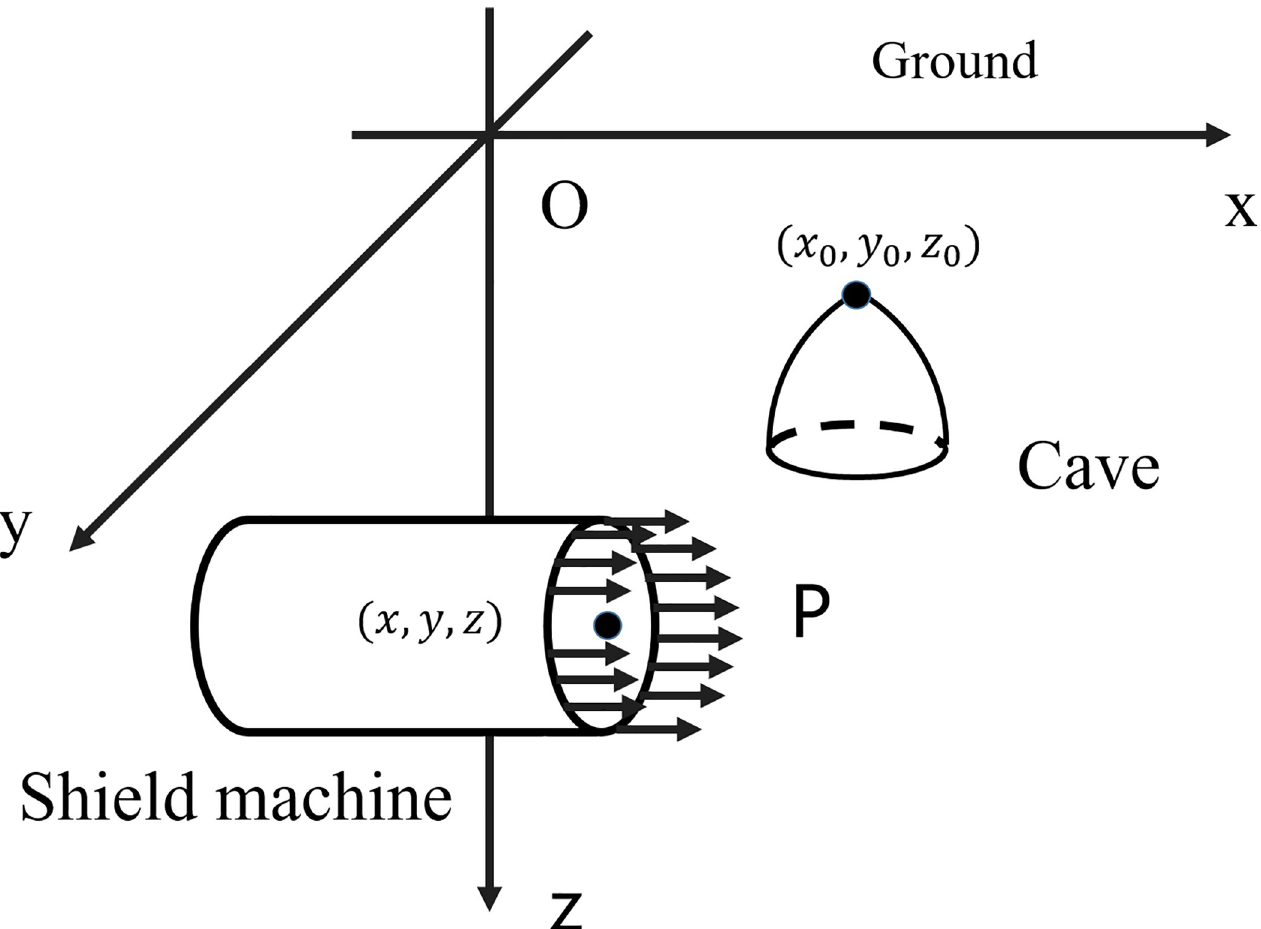
Fig 1. Schematic diagram showing a shield machine passing a nearby karst